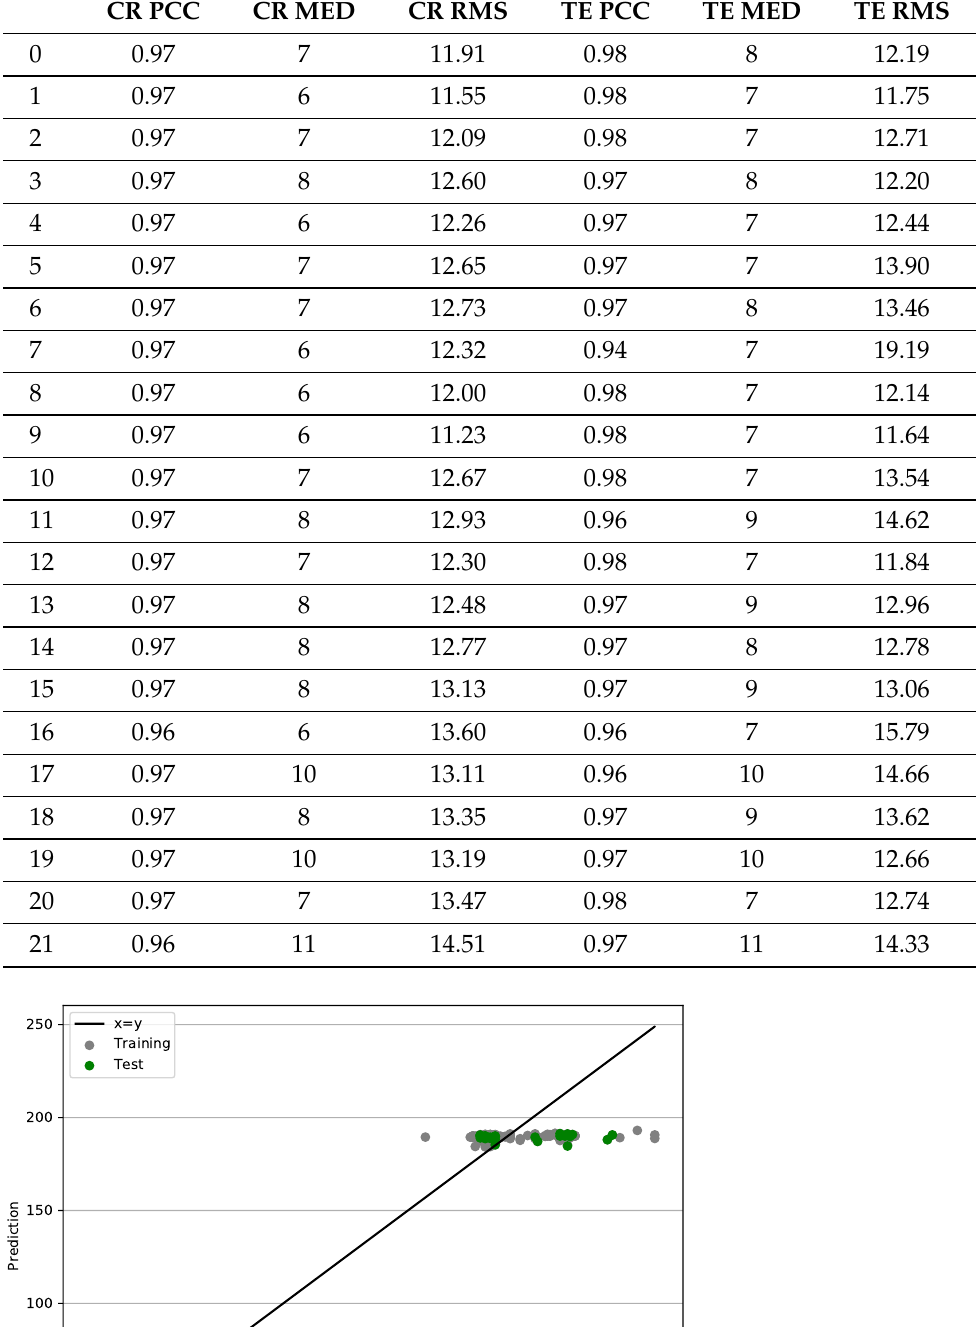
Table 3. Error estimates for 22 selected models for cross-validation (CR) and test sets (TE). Pearson correlation coefficient (PCC), median (MED) and root mean square (RMS) difference in the number of day to flowering between model solution and data.